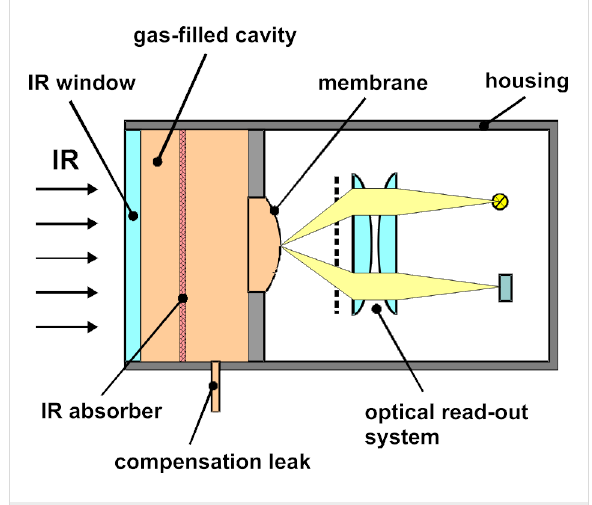
Figure 3: Principle of a gas-filled Golay sensor with optical read-out. For explanations see text.